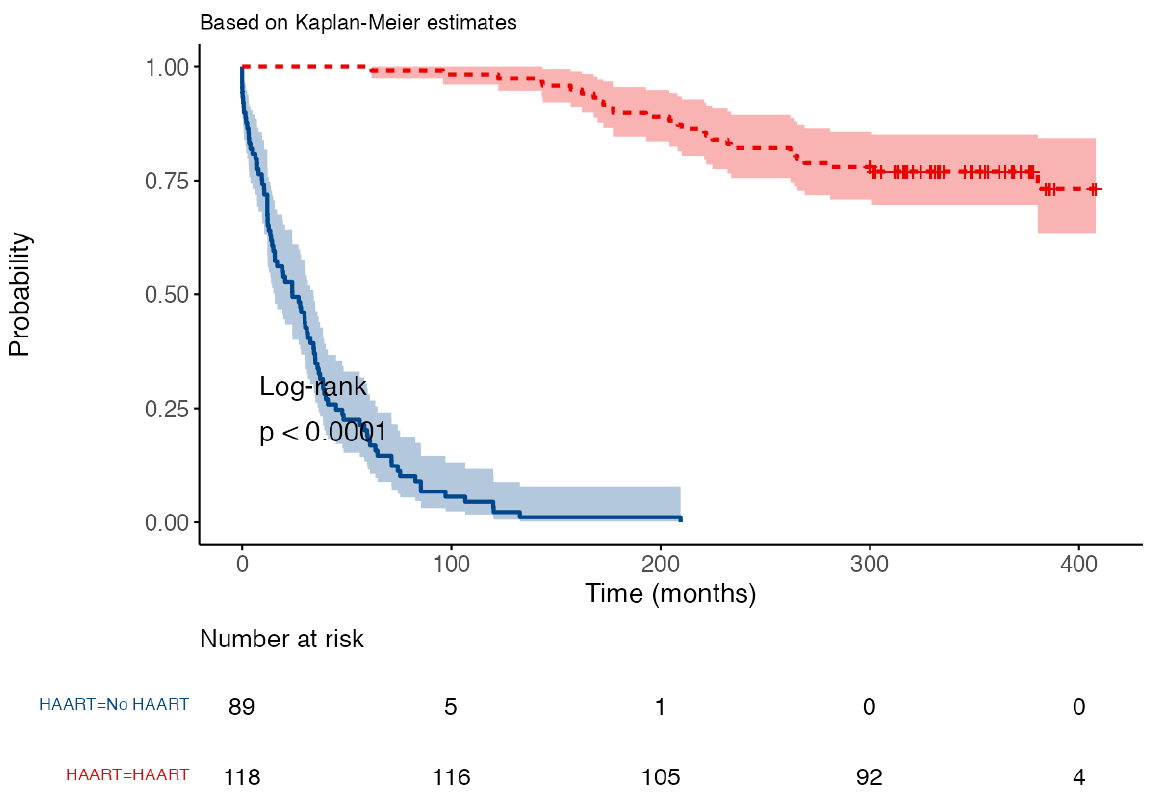
Figure 2. Probability of survival stratified by access to HAART treatment. This figure shows the